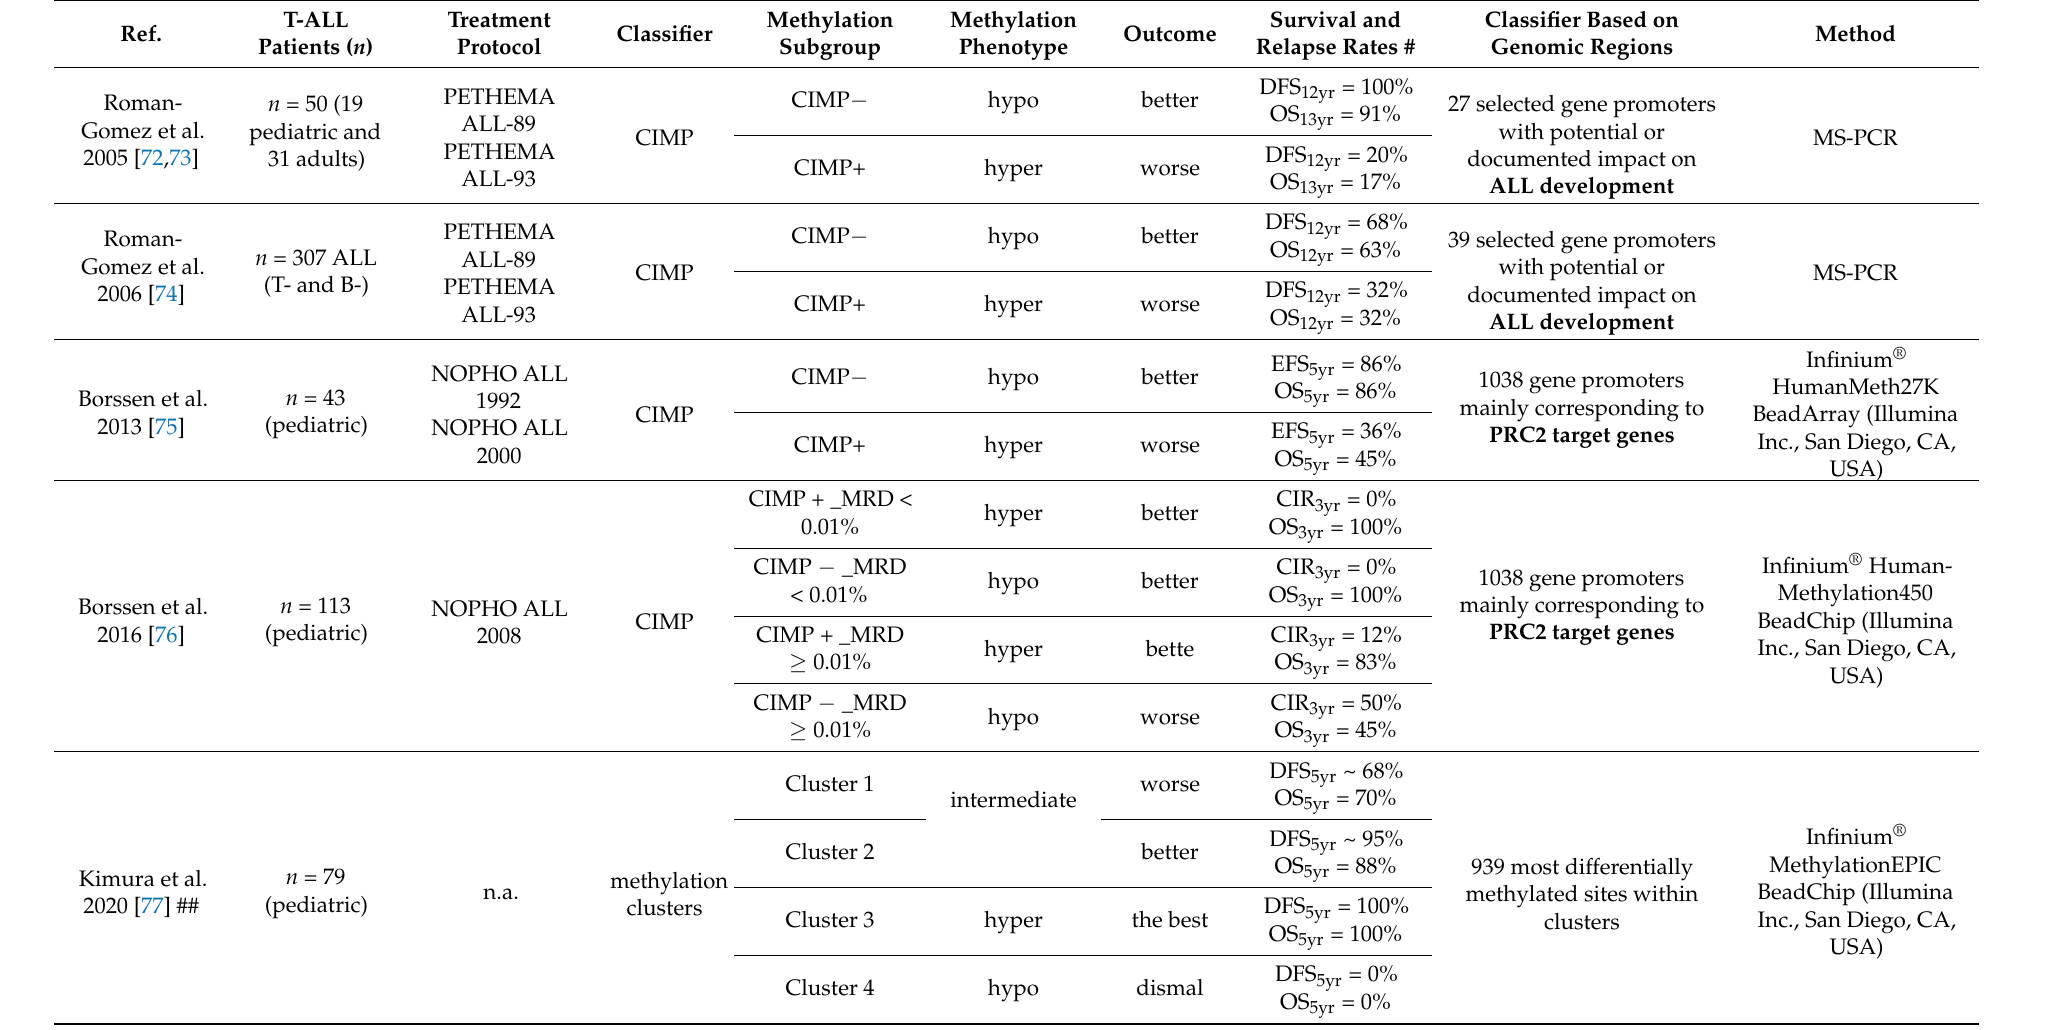
Table 1. Overview of studies reporting prognostic potential of differential DNA methylation in T-ALL